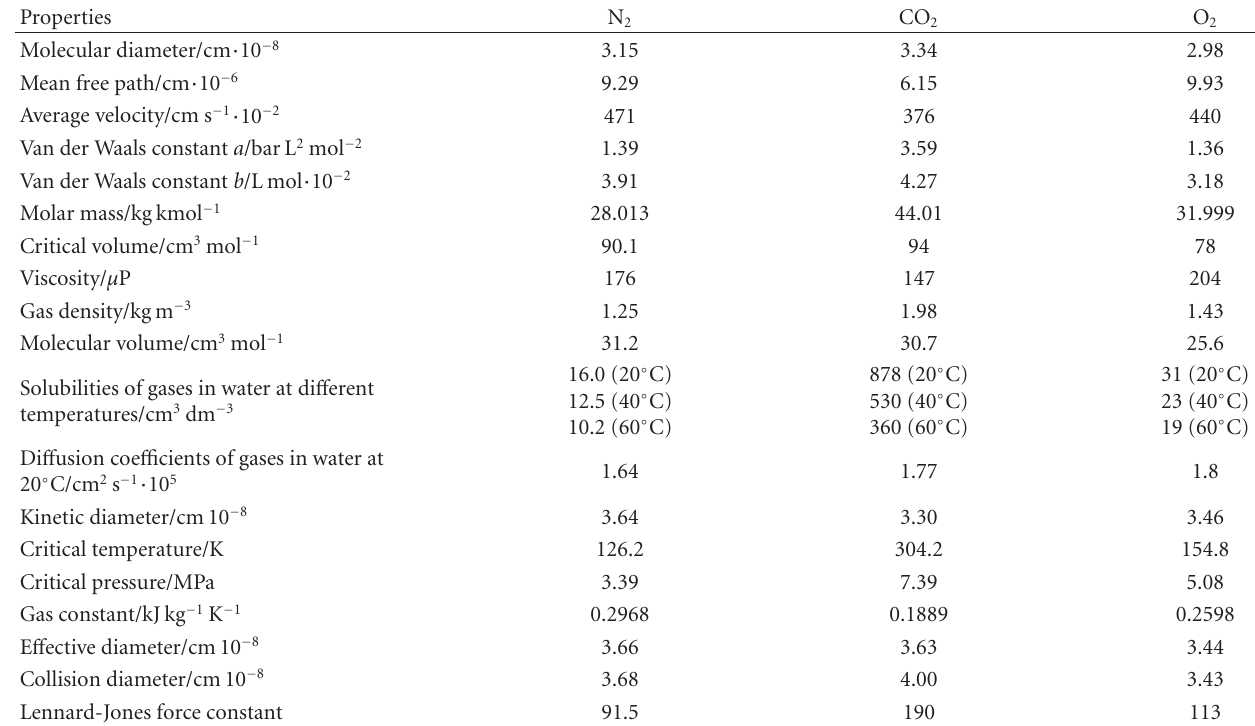
Table 3: The most important properties of gases used in the permeability